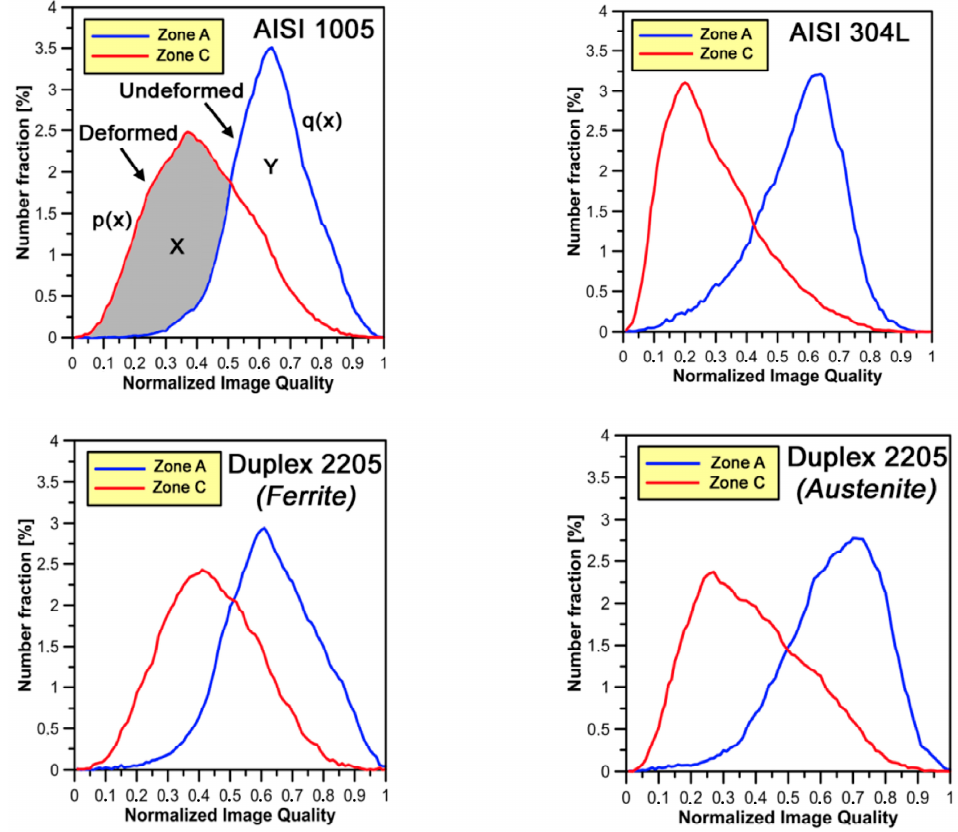
Figure 6. Normalized IQ distribution for various degrees of strain at 20 °C for the two phases on the different steels investigated.